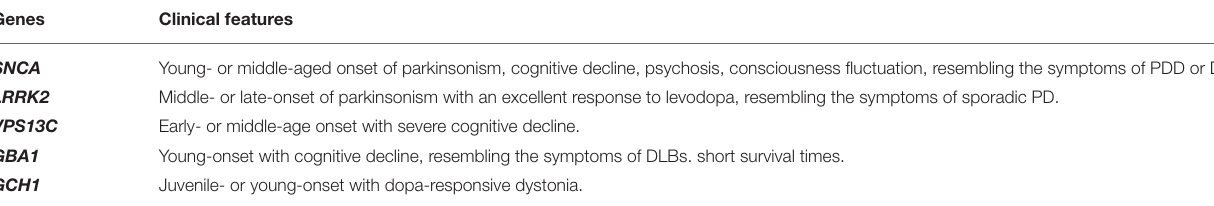
TABLE 2 | Major clinical features for each